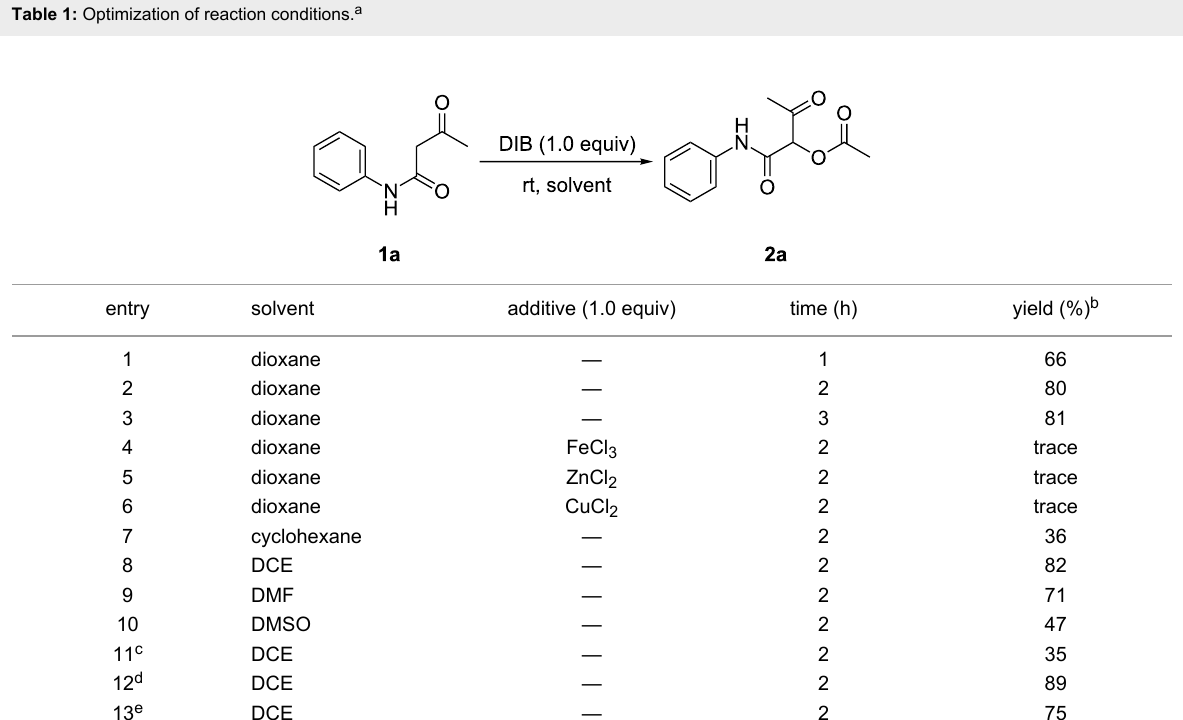
Table 1: Optimization of reaction conditions.